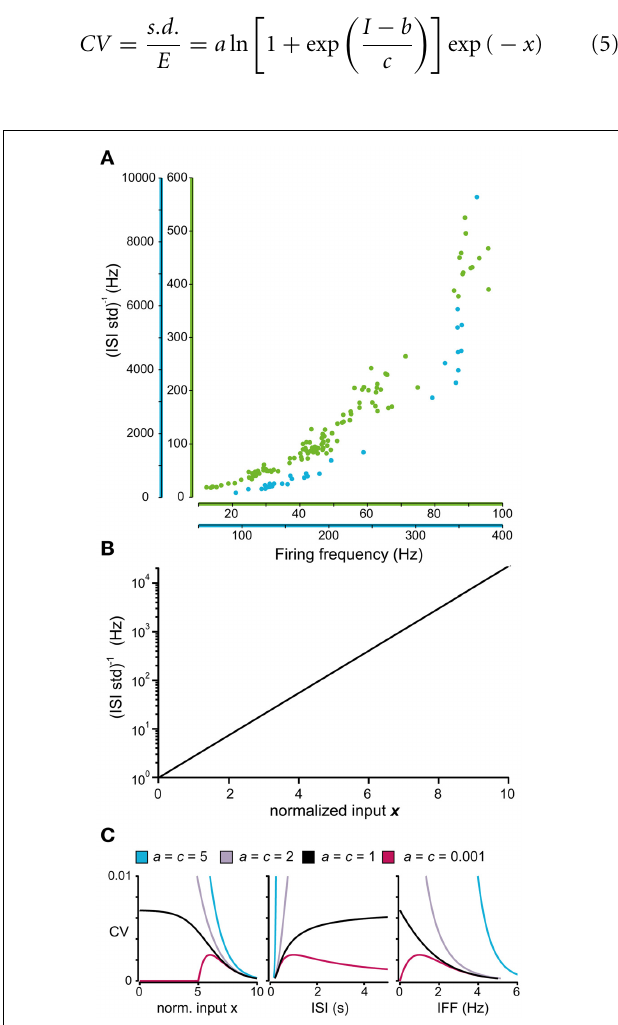
FIGURE 4 | Relationship between firing level and spike firing variability. (A) Relationship between the firing frequency and the inverse of the standard deviation of the ISIs for two sample spinal interneurons. Note that the axes of the firing frequency for the two neurons differ substantially. (B) Model prediction of the relationship between the normalized input and the logarithmic value of the inverse of the standard deviation of the ISI distribution. (C) Predicted coefficient of variation (CV) of the complete model in Equation (6) where the parameters a and c are varied as in Figure 3 . ( C ; left) Relationship between the normalized input and the CV. Note that the CV only reaches a stable value above 0 as the input approaches −∞ (corresponding to a substantial hyperpolarization) if c = 1. Otherwise it either diverges as c > 1 or approach 0 as c < 1. ( C ; middle, right) For comparison with previous results, the CV in relation to the average length of the ISIs (middle) (Softky and Koch, 1993) and the CV in relation to the instantaneous firing frequency (right) (Rauch et al., 2003) is also included in the